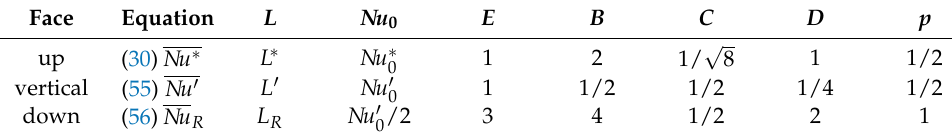
Table 4. Derivation